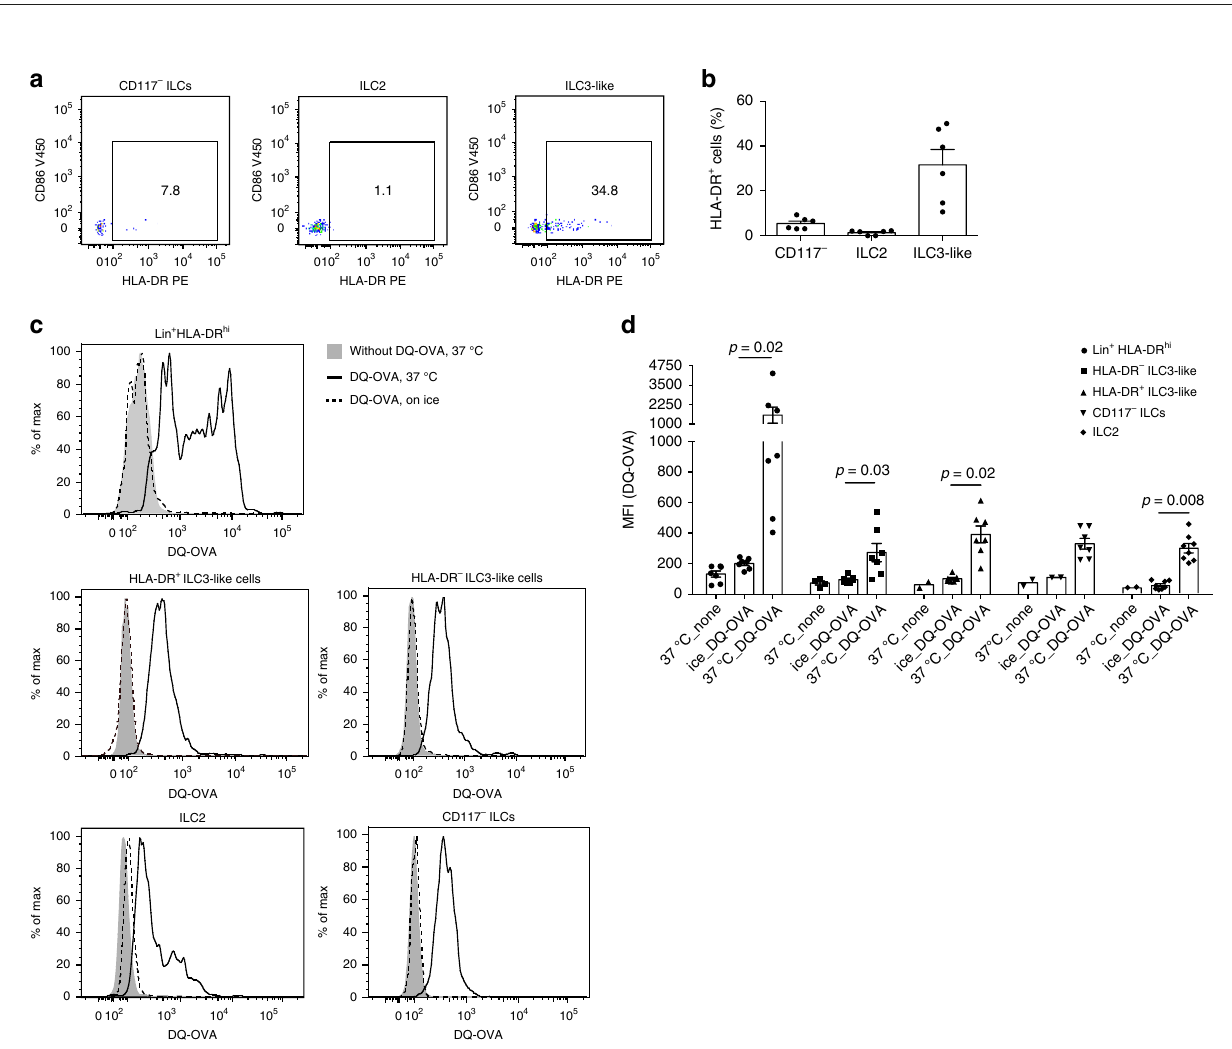
Fig. 2 HLA-DR and co-stimulatory molecule expression on and DQ-OVA uptake by PB ILC subsets. a Representative fl ow cytometric dot plots of HLA- DR and CD86 expression on PB CD117 − ILCs, ILC2 and ILC3-like cells, de fi ned as Lin − CD127 + CD161 + CRTH2 − CD117 − , Lin − CD127 + CD161 + CRTH2 + and Lin − CD127 + CD161 + CRTH2 − CD117 + cells, respectively. b Mean of HLA-DR expression on PB ILC subsets. N (donors) = 6; bars indicate mean value; error bars indicate SEM. c Representative histograms and d summarized data of fl uorescence emission by sort-puri fi ed PB CD117 − ILCs, ILC2, HLA-DR + ILC3- like cells, HLA-DR − ILC3-like cells and Lin + HLA-DR hi cells after 4 h incubation with 10 μ g/ml DQ-OVA. c Gray fi lled histograms depict cells incubated without DQ-OVA, solid black lines show cells incubated with DQ-OVA at 37 °C, and dashed black lines — cells incubated with DQ-OVA on ice. d N (donors) = 7. Due to limited cell numbers, we could not generate data for all conditions for every donor. Bars and error bars indicate mean and